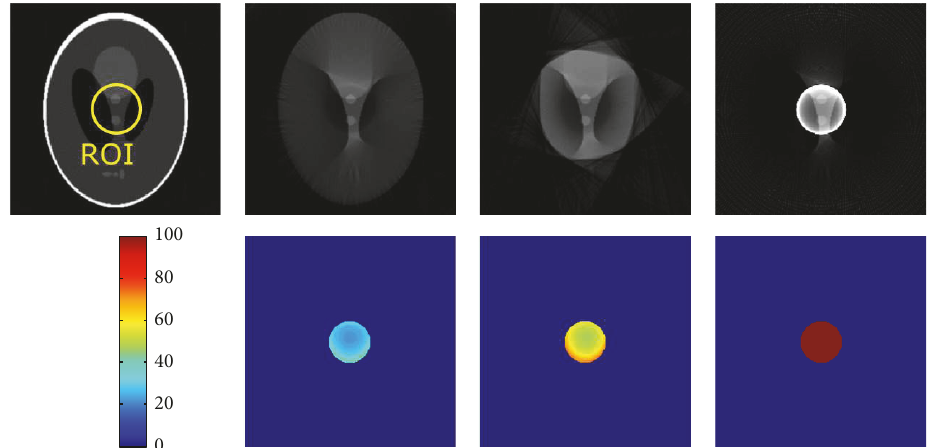
Figure 4: Reconstruction results of Shepp-Logan phantom (radius of ROI: 30 pixels). From left to right: reference from nontruncated data, proposed correction method, water cylinder extrapolation (cf. Berger et al. [8]), and no correction. The grayscale window is [0, 1]